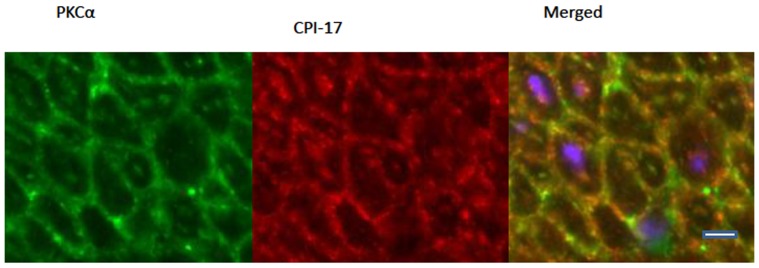
Pig antrum activated with PDBu and reacted with PKCα (left column, green) and CPI-17 (middle column, red) and merged with nuclei (right column, PKCα – green; CPI-17– red; DAPI – blue).Co-localization of PKCα and CPI-17 result in yellow/orange fluorescence. Scale bar = 10 µm.